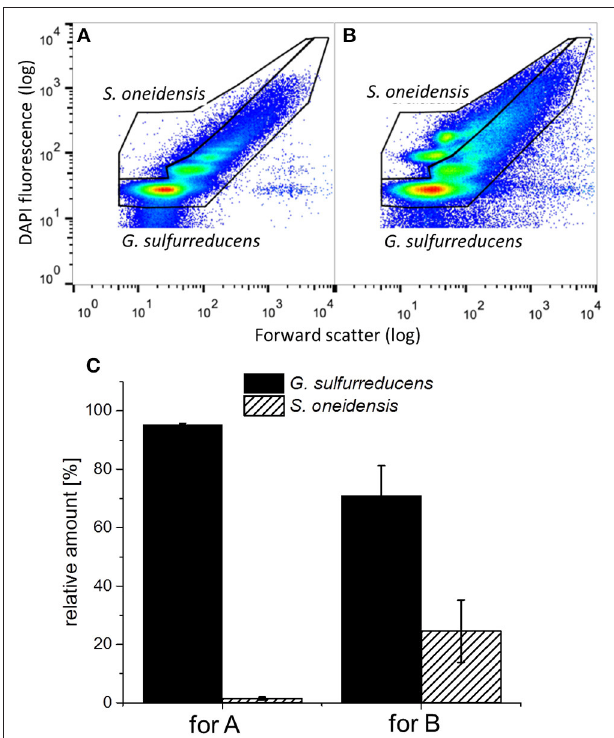
FIGURE 7 | Representative dot plots from (A) the biofilm and (B) planktonic cells of a G. sulfurreducens / S. oneidensis defined mixed culture and (C) the thereof determined relative amount of cells in the G. sulfurreducens gate (filled) and the S. oneidensis gate (diagonally ruled). Error bars in C represent standard deviation from biological